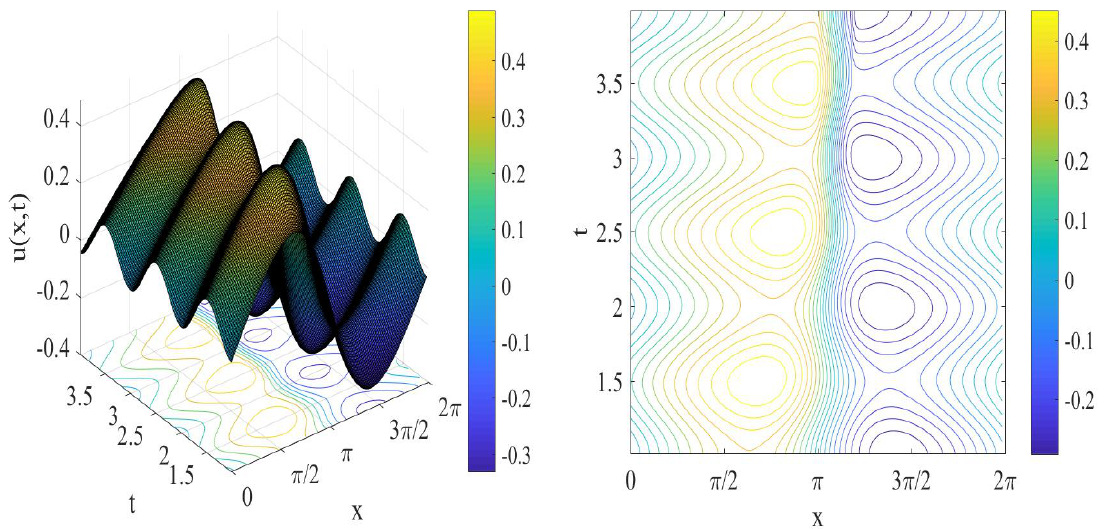
Figure 14. The mean solution ( left ) and its variance ( right ) for the inviscid Burgers’ equation switching at with modes number .   =   =